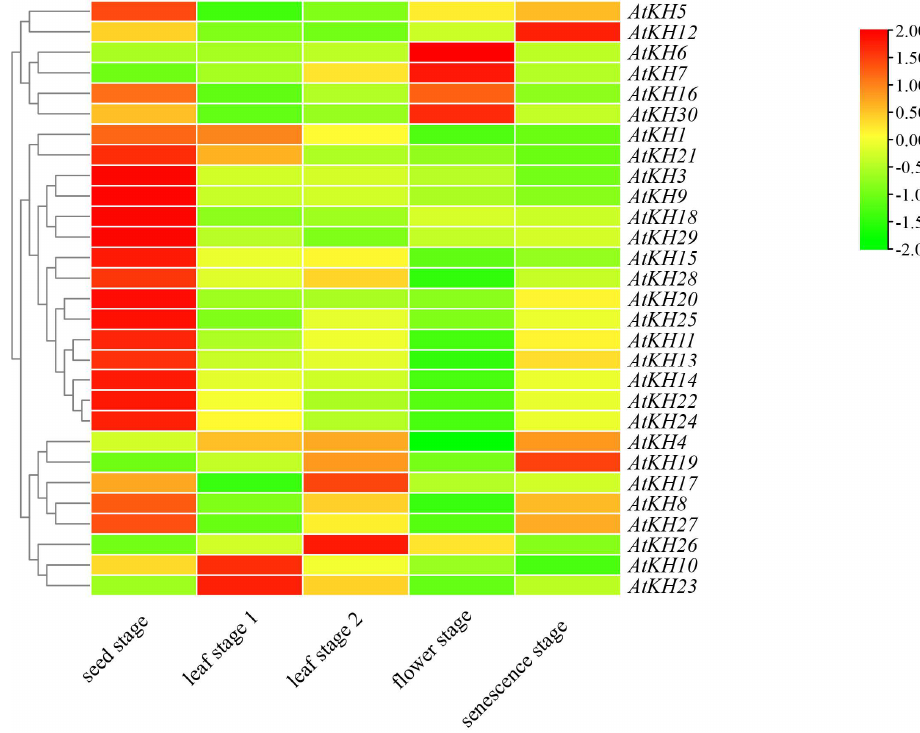
Figure 4. The expression of Arabidopsis thaliana KH domain genes during the growth and development. The growth and development stage of A. thaliana was artificially divided into five stages, namely seed stage, leaf stage 1 (leaf number 1-7), leaf stage 2 (leaf number 8-14), flower stage, and senescence stage.